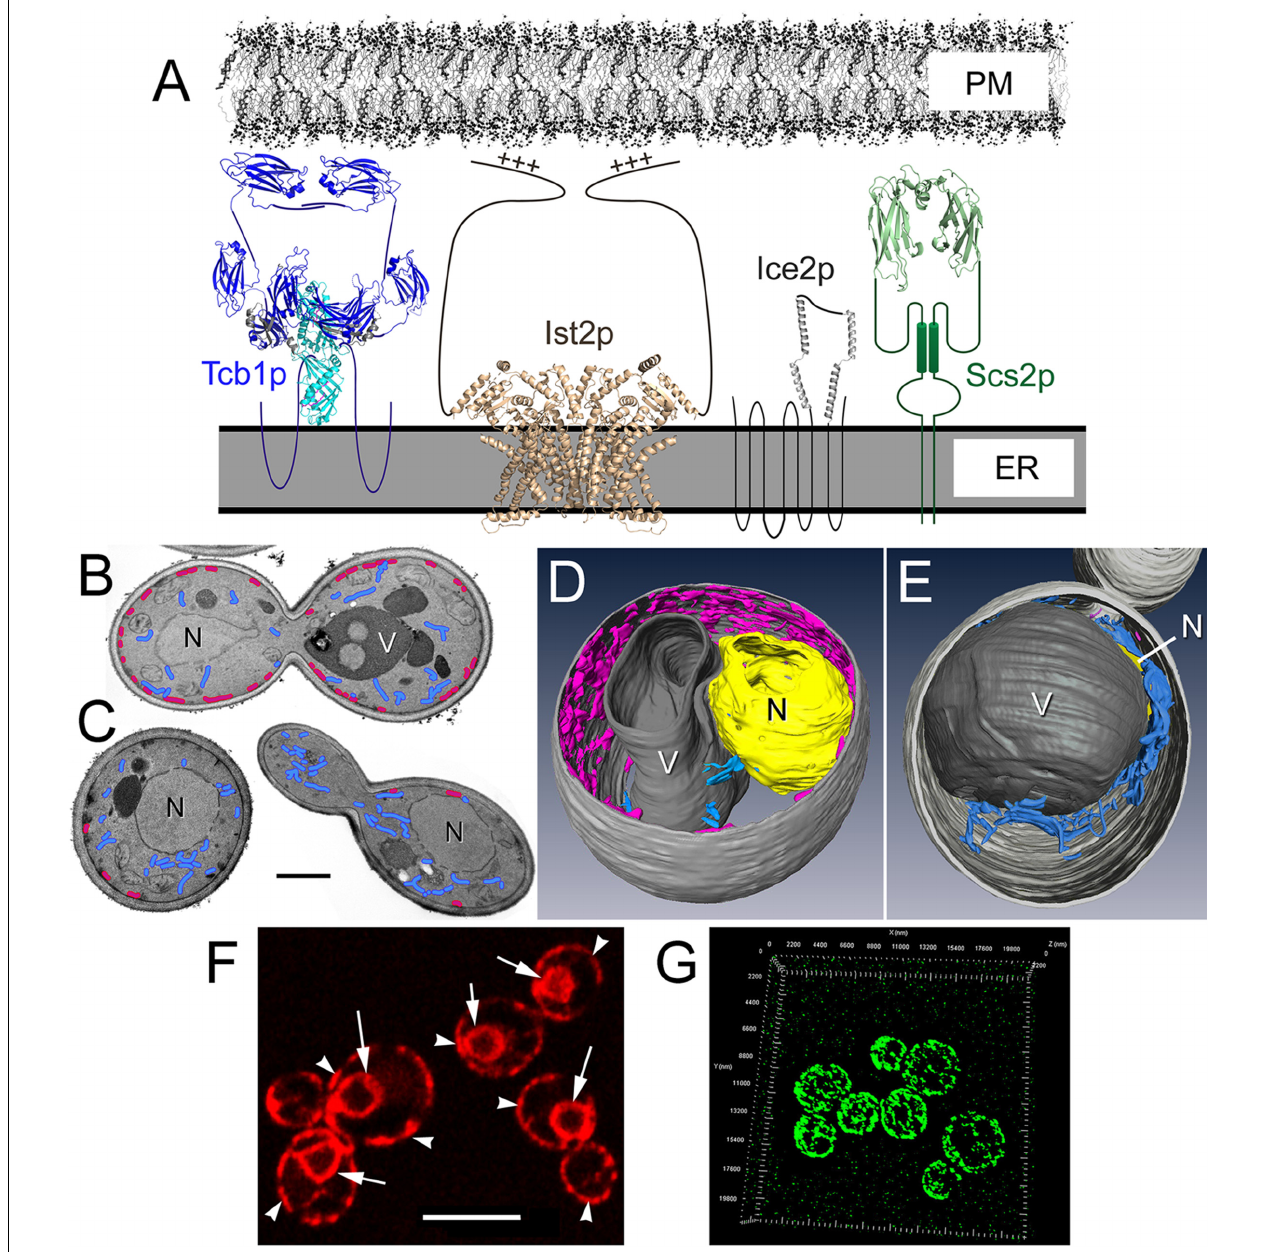
FIGURE 1 | Membrane tether proteins adhere cER membrane to the cytoplasmic face of the PM. (A) Representations of the four classes of yeast primary membrane tether proteins that establish ER-PM MCSs, including: a yeast homolog of E-Syts (Tcb1p); the yeast Anoctamin/TMEM16 homolog (Ist2p); the yeast-specific tether Ice2p; and a homolog of VAP (Scs2p). Structures shown are based on homologous proteins, and unstructured elements are represented as simple lines. The Tcb1p dimer representation is shown in the “tunnel model” configuration (Schauder et al., 2014), and structural elements are based on the mammalian E-Syt2 SMP-C2a-C2b domain (PBD ID: 4P42 and 2DMG); C2 domains are dark blue (Tcb1p has 4 C2 domains where E-Syt2 has 3 as shown) and SMP domains are light blue. The Ist2p dimer is based on the TMEM16 lipid scramblase structure PBD ID: 4WIT with the PM-binding C-terminal with the polybasic region indicated (+++). The structure for Ice2p has not been determined though based on its four predicted helical segments and the length of the third cytoplasmic loop, it could extend ∼ 10 nm from the ER membrane. The Scs2p dimer structure is represented by the VAP-A MSP homology domain (PBD ID: 1Z9L). Estimated model sizes are to scale with the ER and PM shown ∼ 20 nm apart. (B) Representative transmission electron microscopy (TEM) images of wild-type yeast and (C) (cid:49) -s-tether cells showing cER (magenta) distribution along the PM and cytoplasmic ER (blue). Only small regions of ER-PM association persist in (cid:49) -s-tether cells. N, nucleus; V, vacuole. Bar = 1 µ m. (D) Representative wild-type and (E) (cid:49) -s-tether cells modeled from 3-D constructions of sections imaged by focused-ion beam scanning electron microscopy (FIB-SEM); cER is shown in magenta, cytoplasmic ER in blue. V, vacuole; N, nucleus (yellow; in the (cid:49) -s-tether cell the nucleus is partially hidden underneath the vacuole). (F) RFP-ER fluorescence marks normal nuclear (arrows), cytoplasmic, and cER (arrow heads). Bar = 5 µ m. (G) 3-D representation of super-resolution micrograph image stacks showing Tcb3p-GFP cortical fluorescence at ER-PM MCSs.